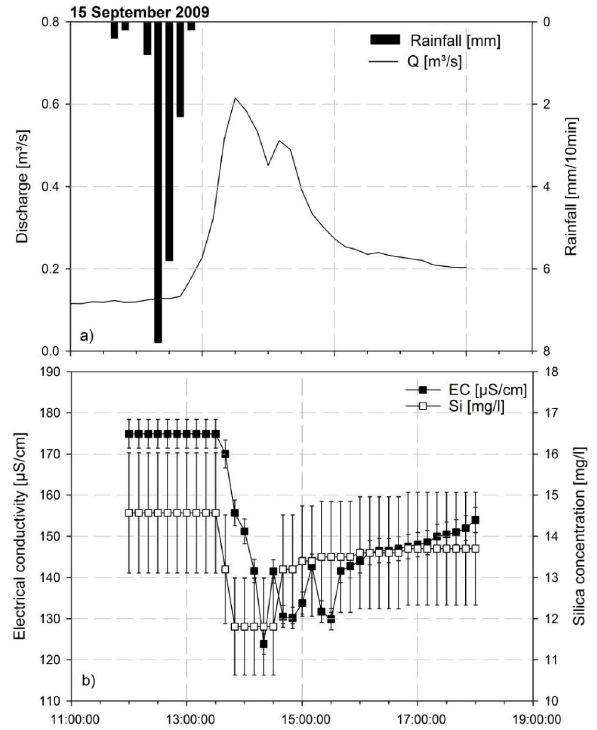
Fig. 6. Event on 15 September 2009 (E5) showing (a) rainfall and discharge and (b) EC values and silica. Error bars indicate measure- ment uncertainty of 2% for EC and 10% for